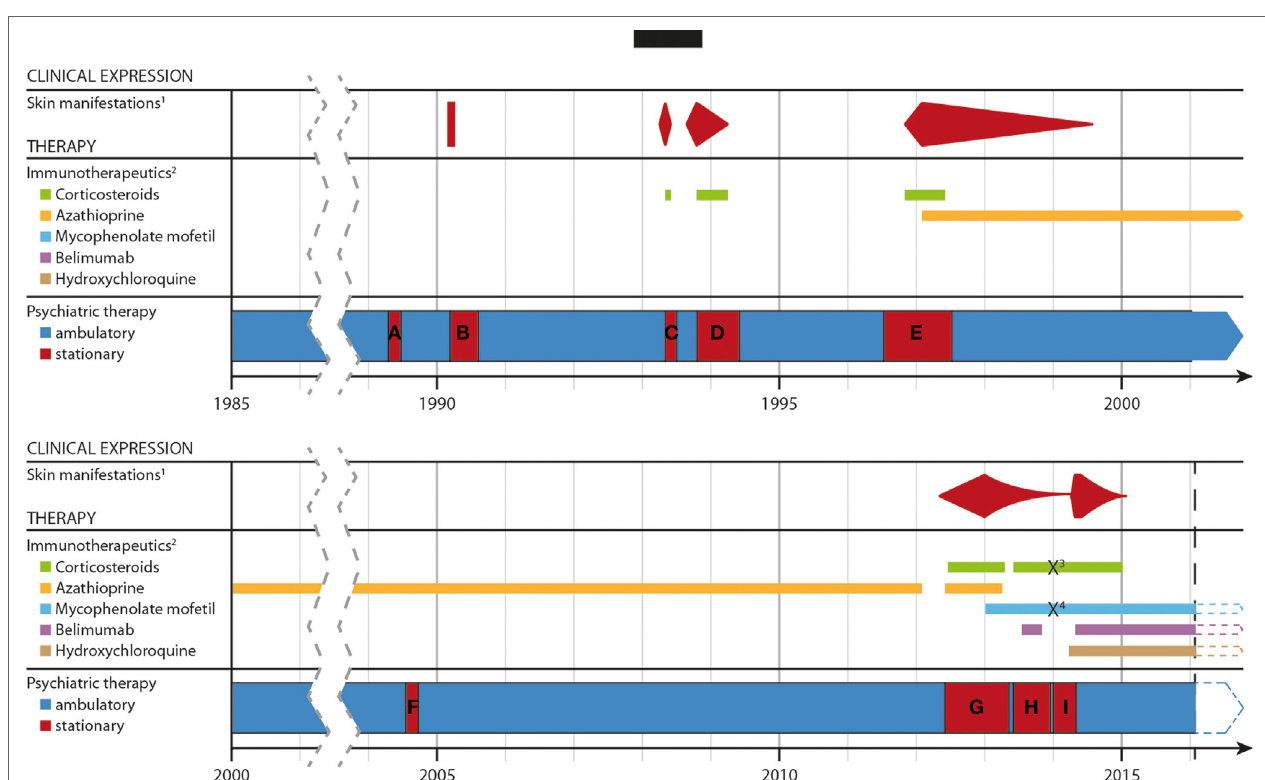
FIGURe 2 | Timeline of the development of the disease, the severity of the skin lesons and immunotherapeutic treatments over time. Abbreviations and explanations: 1 well documentated, specific cutaneous, and mucosal lesions; 2 except for topical application; 3 / 4 methylprednisolone/mycophenolate mofetil was paused due to a suicide attempt. (a–G) period of stationary treatment: (a) 14.04.–23.06.89; (B) 15.02.–11.07.90; (C) 11.03.–27.07.90; (D) 20.08.93–30.03.94; (e) 11.06.96–12.06.97; (F) 19.07.–25.09.2004; (G) 29.05.12–03.05.13; (H) 29.05.–13.12.1; (I) 03.01.–30.04.14 and 01.05.–06.05.14.